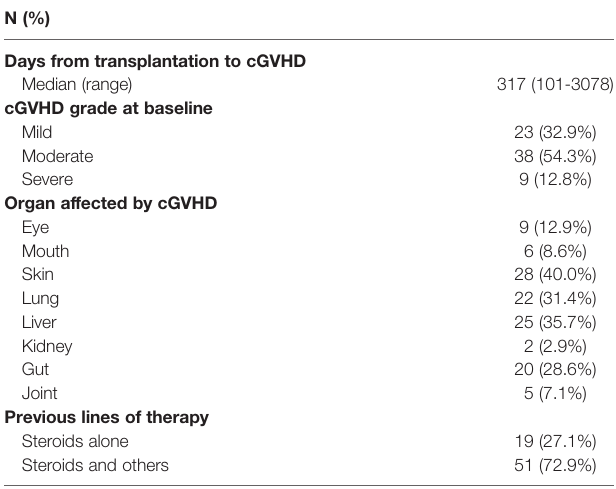
cGVHD, chronic graft-versus-host